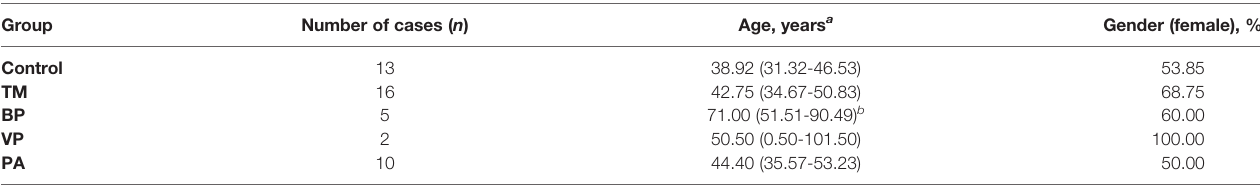
TABLE 1 | Characteristics of healthy controls (Control), and patients with T. marneffei infection (TM), bacterial pneumonia (BP), viral pneumonia (VP), and pulmonary aspergillosis (PA).